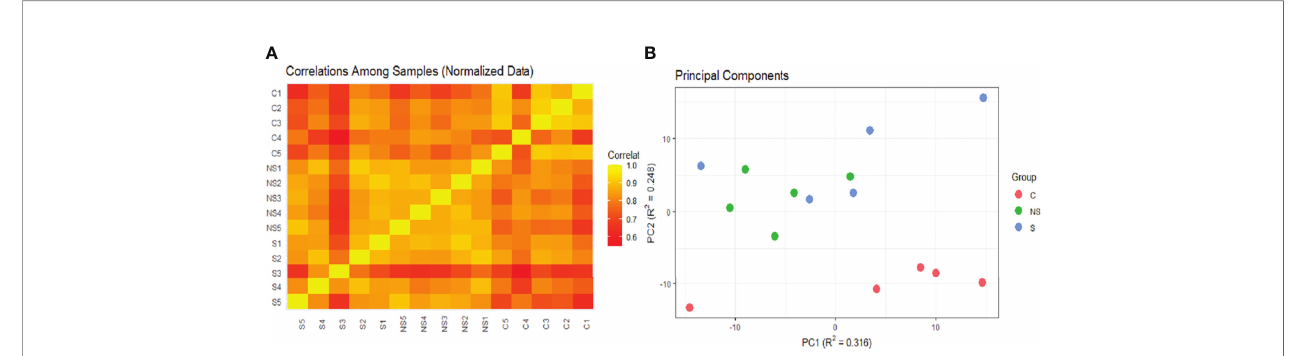
FIGURE 5 | Heatmap of correlations and PCA of samples. (A) Heatmap constructed based on Pearson correlation matrix. (B) Probabilistic PCA. Both images were analyzed and created in pmartR. The Control group (C) is represented by red dots, COVID-19 survivors (S) by blue dots, and COVID-19 non-survivors (NS) by green